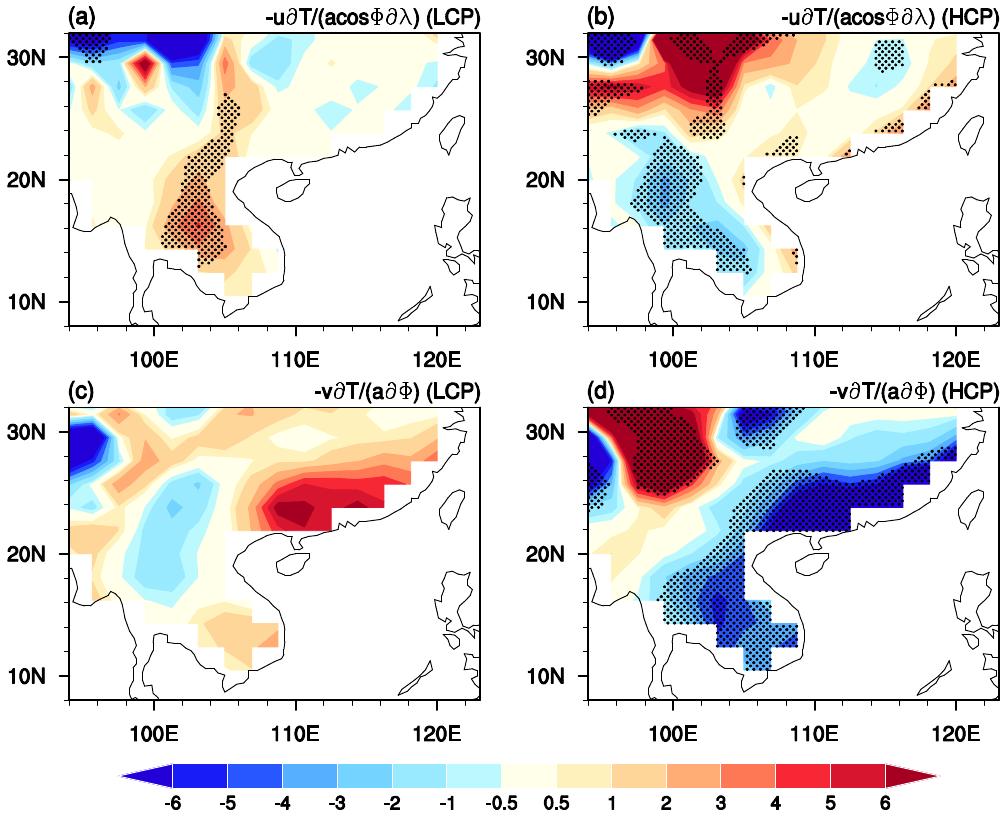
Figure 6. Anomalies of zonal ( a , b ) and meridional ( c , d ) advection of surface air temperature at winter regressed on the standardized winter AO index during (left) 1972–1987 and (right) 1997–2012, respectively. Anomalies significant at the 5% level are stippled. Units are °C (3 month) −1 in ( a )–( d ).